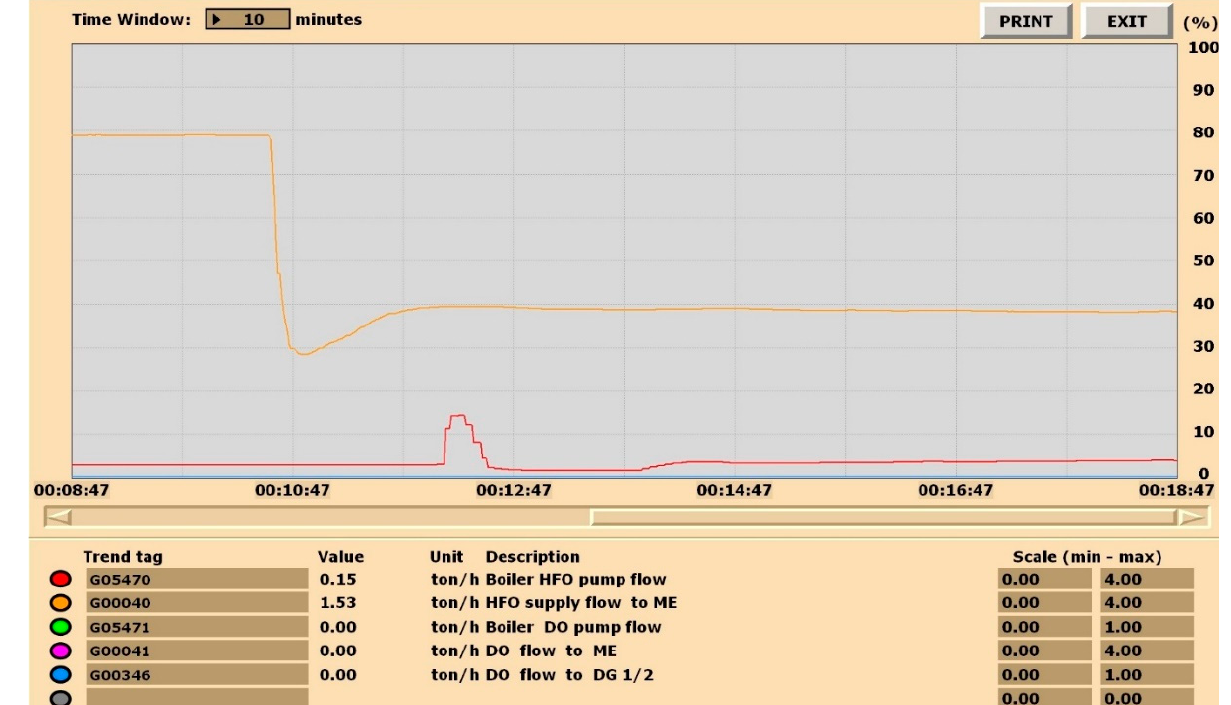
Figure 2. Fuel flows for mode 1.2.